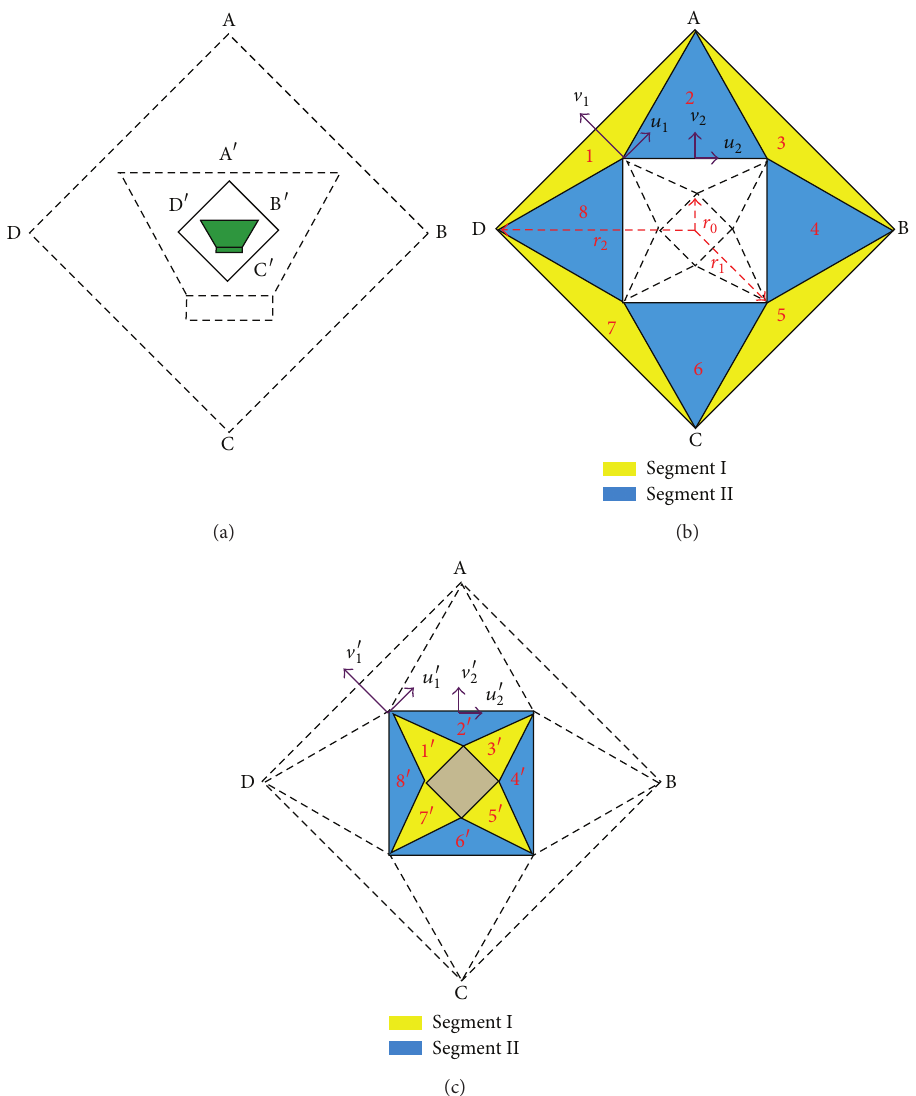
Figure 1: (a) The schematic of the square antenna system. A big square region (ABCD) with radius 𝑟 2 has been compressed to a small one (A 󸀠 B 󸀠 C 󸀠 D 󸀠 ) with radius 𝑟 0 . Green region represents the antenna device compressed from a large size one described by dashed lines. (b) The square in the virtual coordinate space filled with isotropic material is divided into several triangle segments grouped by Segment I and Segment II. (c) The square metamaterial shell in the physical coordinate space is constructed by the transformed segments with homogeneous constitutive